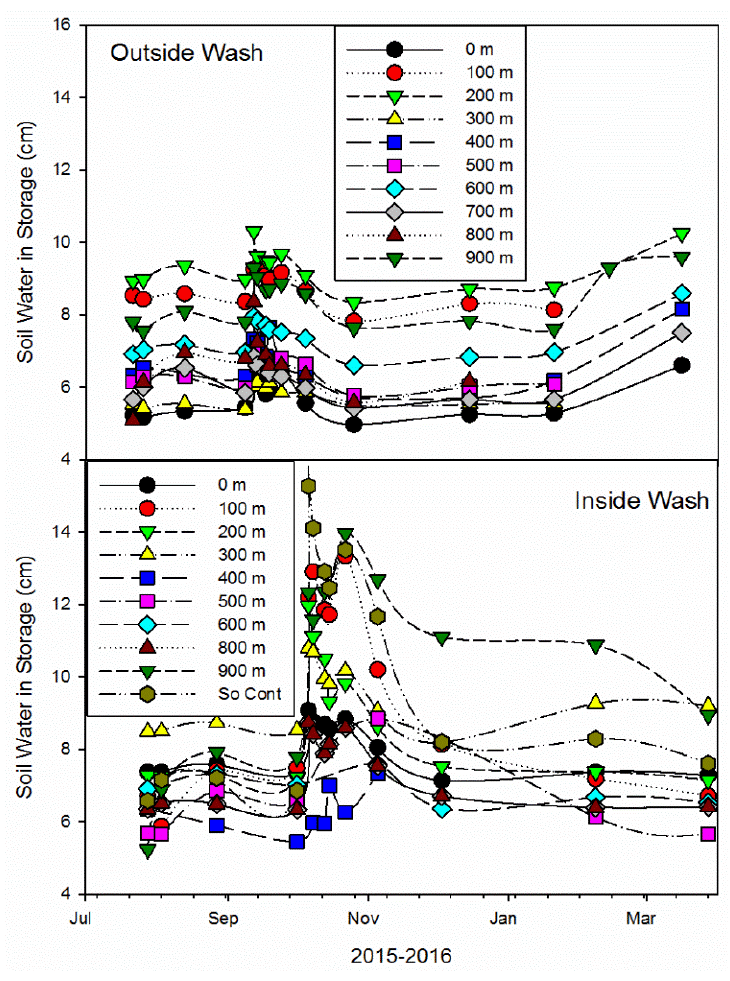
Figure 4. Soil water in storage (cm) estimated along the 900 m gradient inside and outside of the wash. Also included are estimates at a control site within the wash system upgradient and south of the solar facility (South Control). During seven of the ten dates in 2015–2016, the average soil water in storage was higher in the wash than outside of the wash ( p < 0.05).